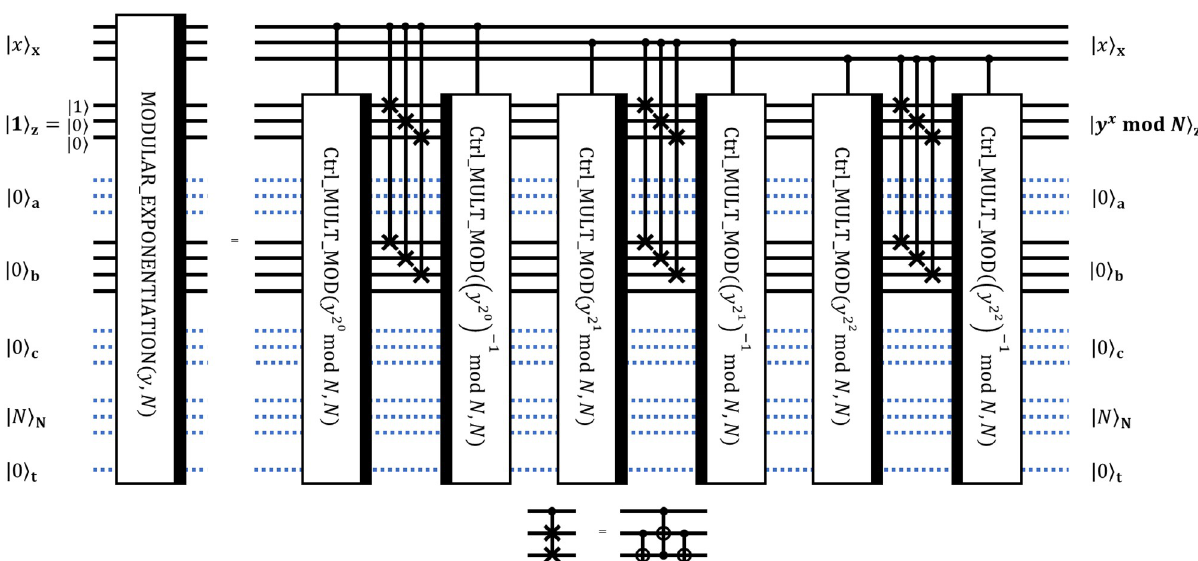
Fig 7. Decomposition of MODULAR_EXPONENTIATION circuit into lower-level operations. The decomposition realizes modular exponentiation y x mod N given 3-bit integers x , y , and N .